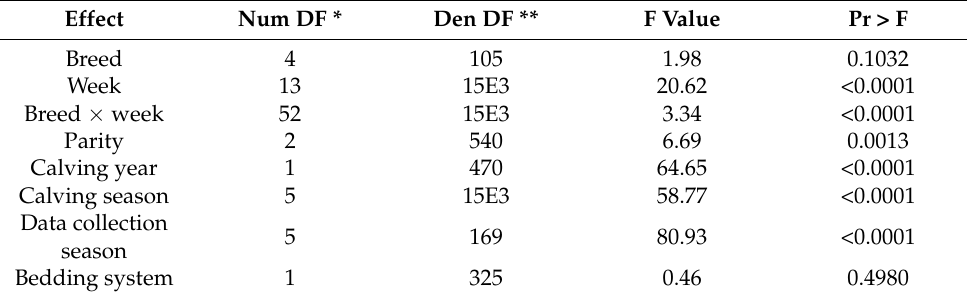
Table A14. Variance analysis results for the variable somatic cell score